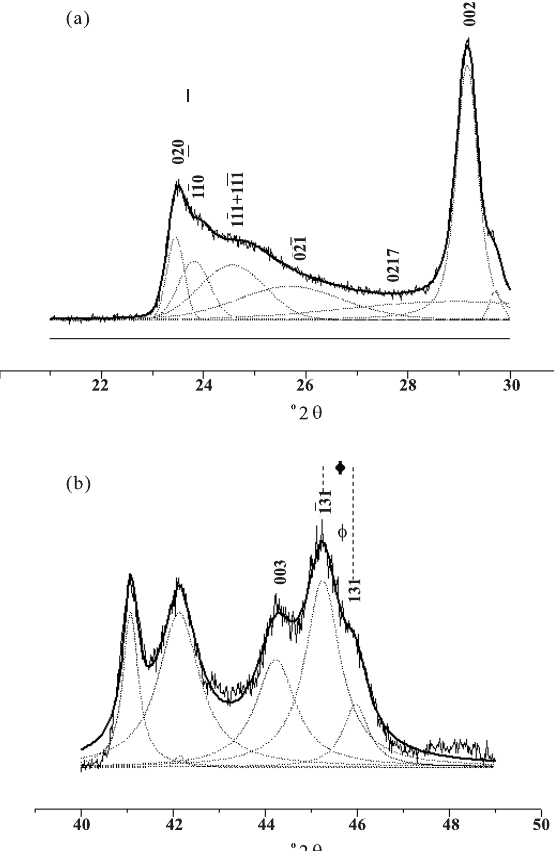
Figura 4. Parte do espectro de DRX da caulinita fina estudada. a: bandas 111 e 021; b: banda